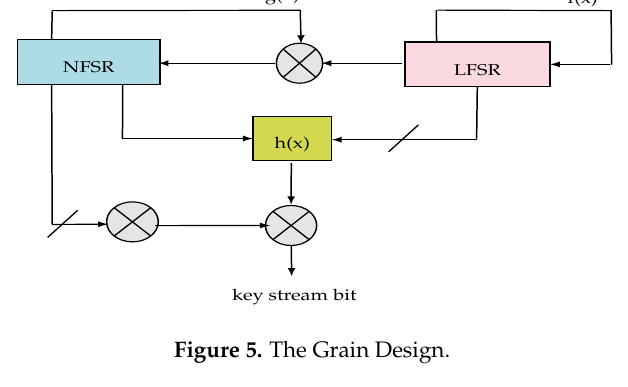
Figure 5. The Grain Design.